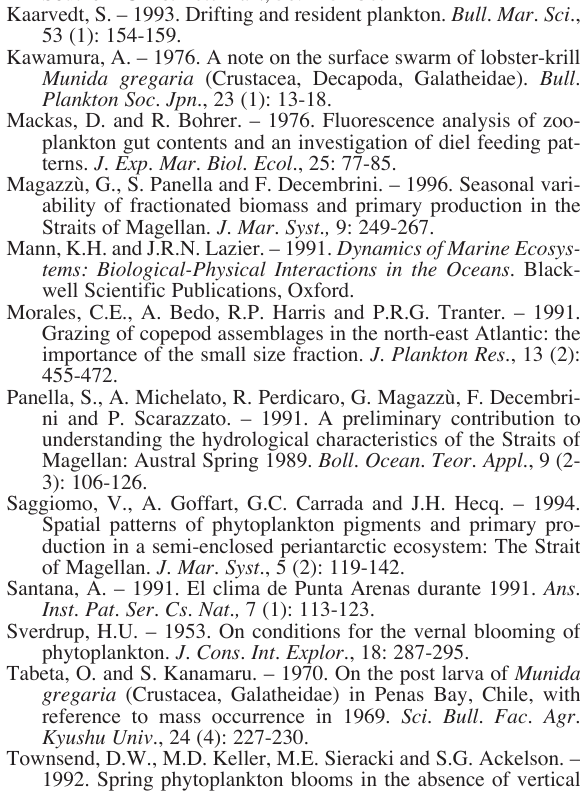
Figueroa, D. and G. Yuras. – 1996. Physical oceanography of the Strait of Magellan in spring. Ber. Polarforsch ., 190: